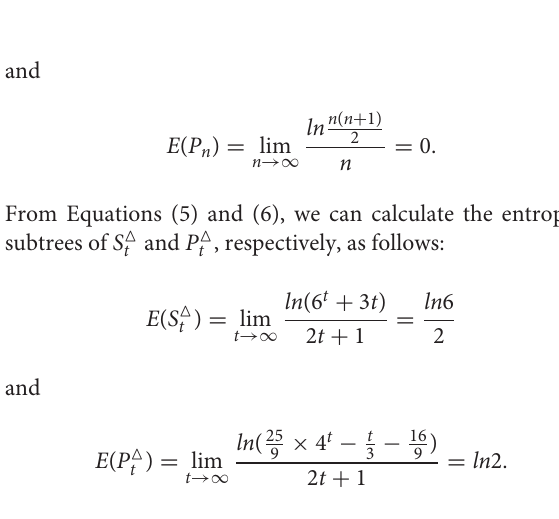
FIGURE 7 | Another construction of Koch networks. The network after g iterations, G m , g , consists of 3 m copies of G m , i labeled by G j m , i ( j = 1,2, ... ,3 m ; i = 0,1,2, ... , g − 1).